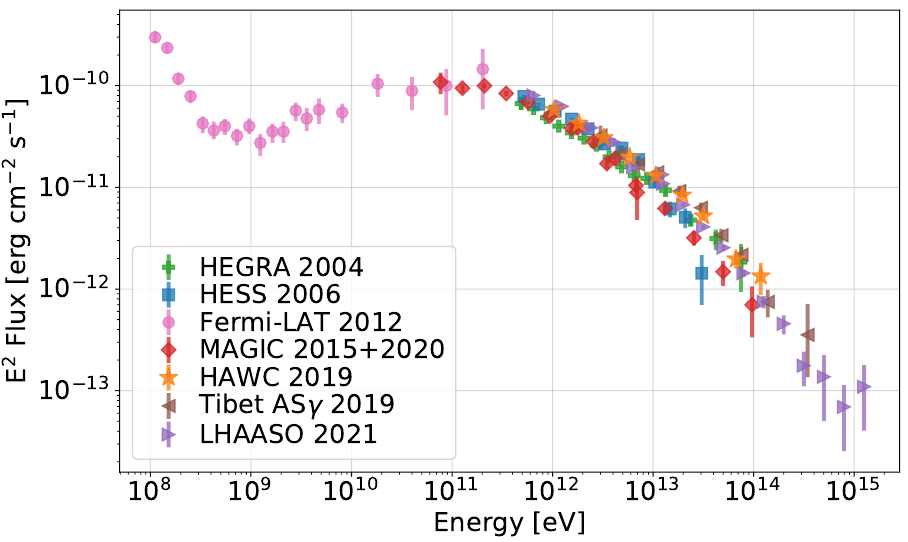
Figure 1. Focus on the gamma-ray spectrum of the Crab nebula. Data from different instruments are shown with diverse symbols/colors—namely, green rectangles for HEGRA data [54], blue squares for HESS data [55], pink circles for Fermi -LAT ones [56], red diamonds for MAGIC data [57,58], orange stars for HAWC [59], brown triangles for Tibet AS- γ [60], and violet ones for LHAASO data [61]. Figure courtesy of Michele